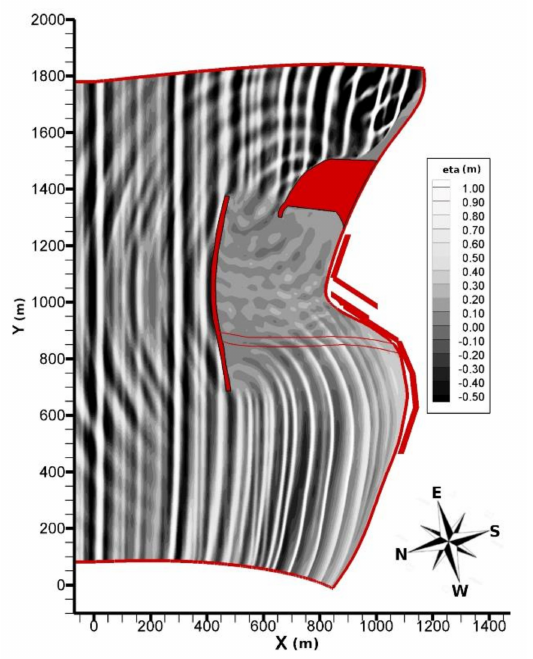
Figure 9. Instantaneous wave field. Present sea bottom level. Configuration